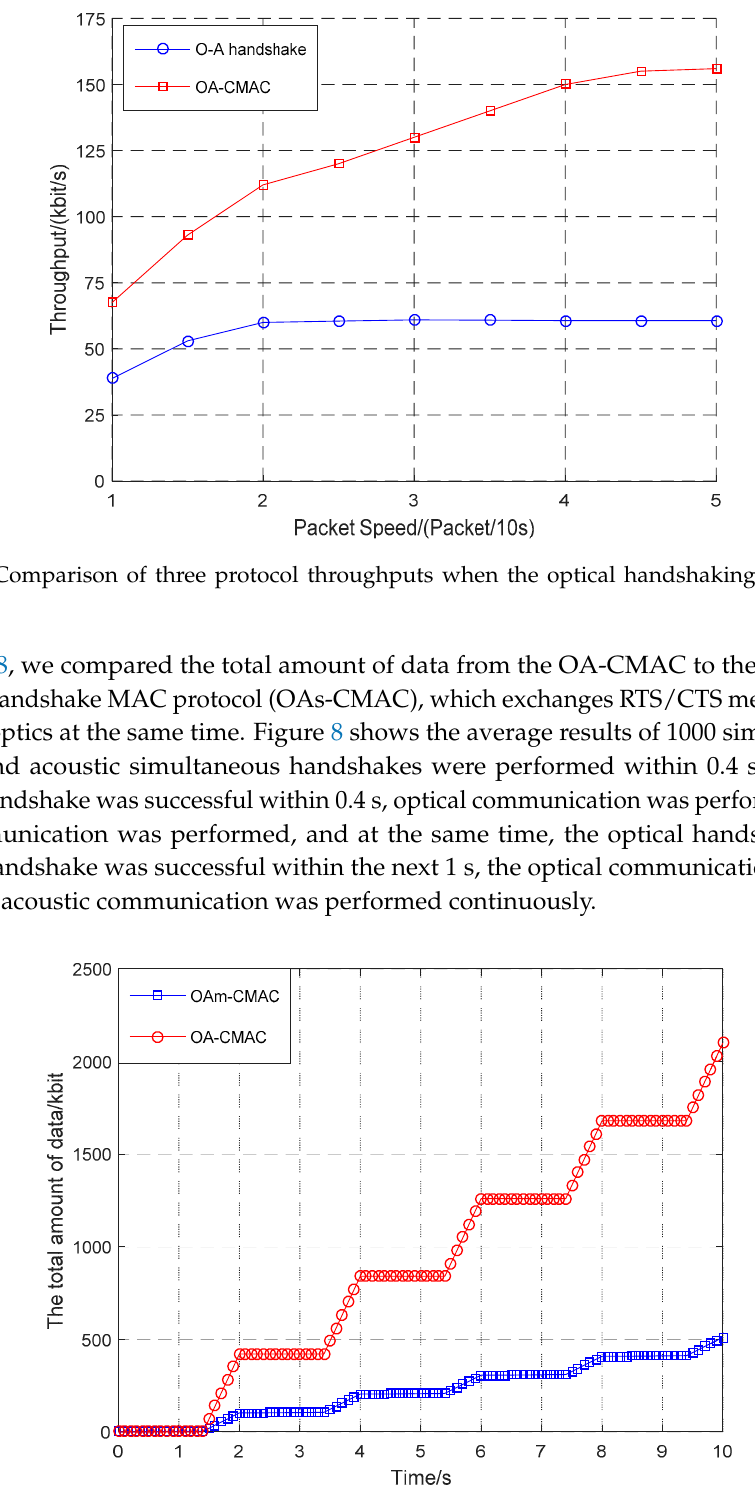
Figure 8. Comparison of the two protocols’ total data volume.